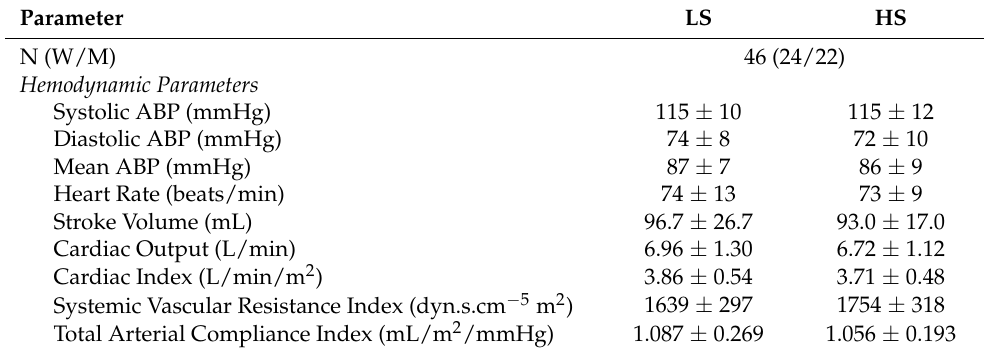
Table 3. Hemodynamic Responses to a 7-Day High-Salt Diet in Young, Healthy Individuals. Parameter